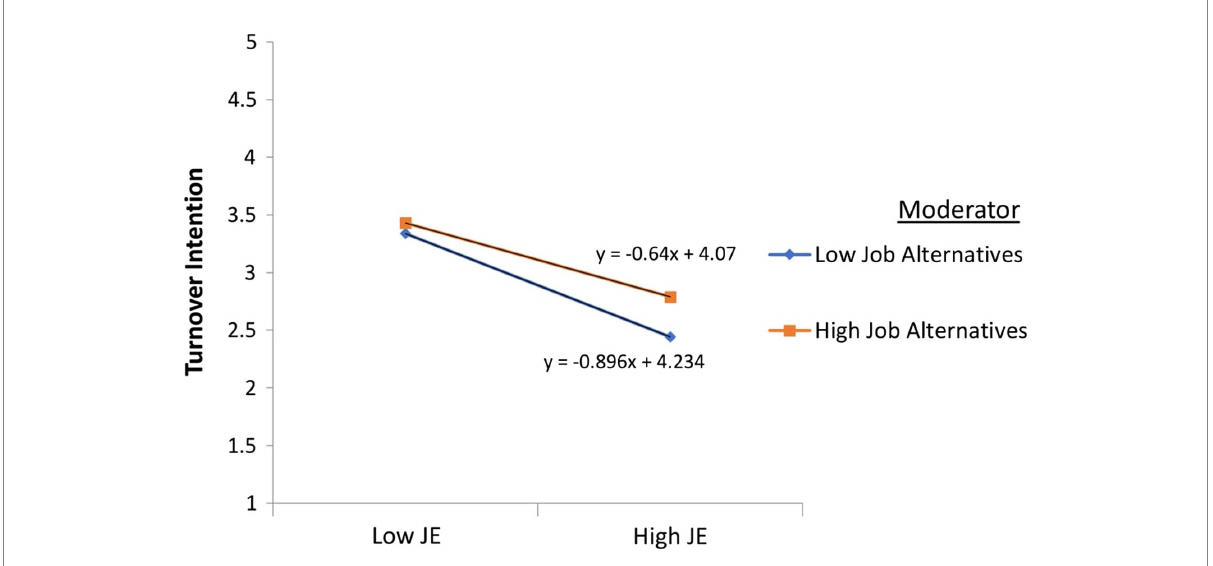
FIGURE 2 Moderating effect of perceived job alternatives on job engagement and turnover intention